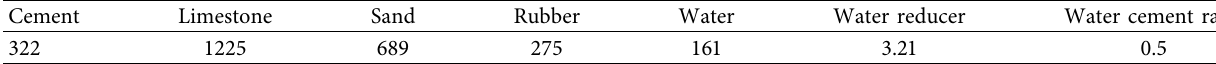
Figure 1: The (a) appearance and (b) microstructure of the rubber particles. Table 3: Mix proportions of RC (kg/m 3 ).